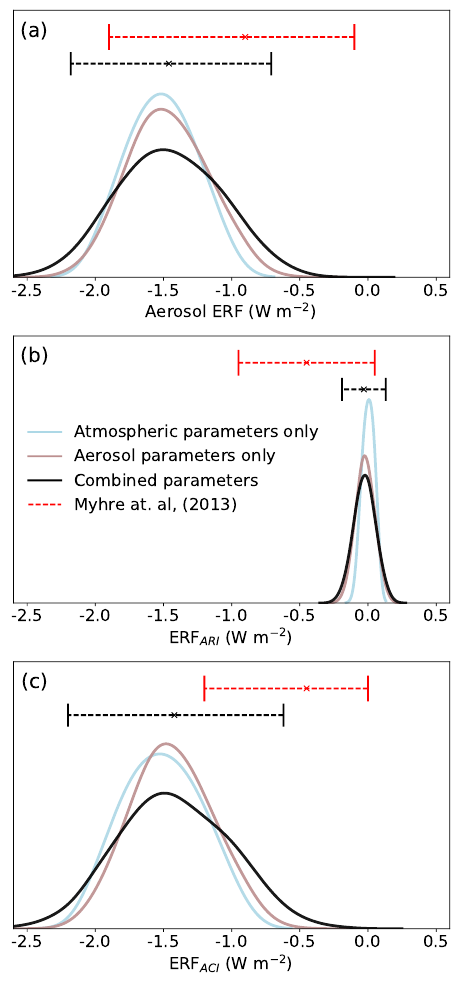
Figure 1. Probability density functions of 1850–2008 (a) aerosol ERF, (b) ERF ARI and (c) ERF ACI . Each sample contains 270000 emulator-derived model variants informed by the expert-elicited prior probability distributions of parameter values. Samples with aerosol and atmospheric parameter uncertainties neglected (Table 1) were obtained by setting each neglected parameter to its median value in the corresponding pdf. Ninety-percent credible intervals from Myhre et al. (2013) are presented as red horizontal lines, with best estimates marked using crosses. Our 95% credible intervals are presented in black, and the sample median is presented using a